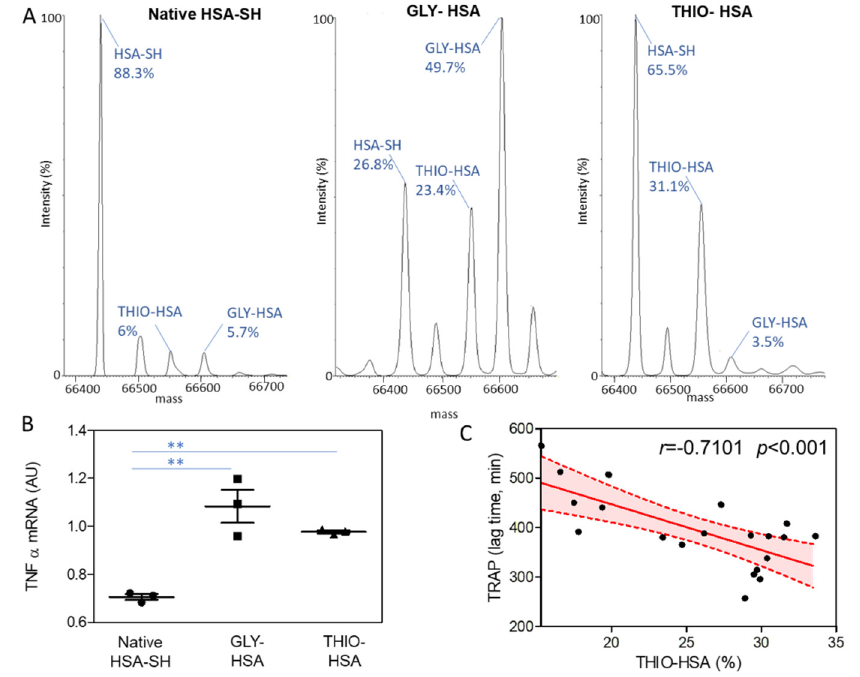
Figure 4. Albumin isoforms and functional effects. ( A ) Mass spectrometry analysis of regenerated HSA (native HSA-SH), highly glycated albumin (GLY-HSA), and highly thiolated albumin (THIO- HSA). ( B ) TNF α mRNA levels, normalized to the housekeeping gene 18S rRNA, in U937 cells incubated with native HSA-SH, GLY-HSA, and THIO-HSA 100µg/mL for 2 h. ** p < 0.01 vs HSA-SH. ( C ) Correlation of THIO-HSA and plasma antioxidant activity measured by means of TRAP assay. Plot shows fitted linear regression line with shaded 95% confidence interval.